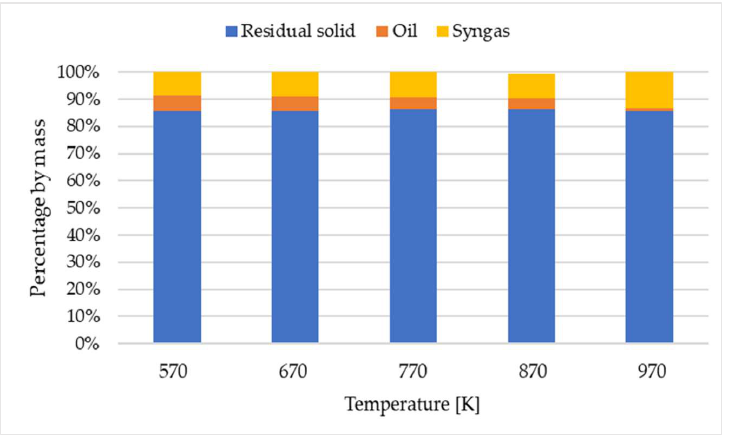
Figure 6. Effect of temperature on pyrolysis products.